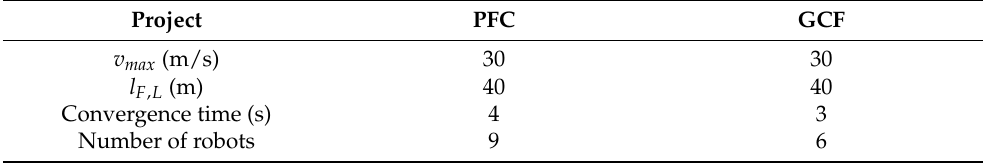
Figure 14. ( a ) Trajectories of ten robots on the plane by GCF in spiral formation; ( b ) Formation position error of each following robot. Table 1. Data comparison table between PFC and